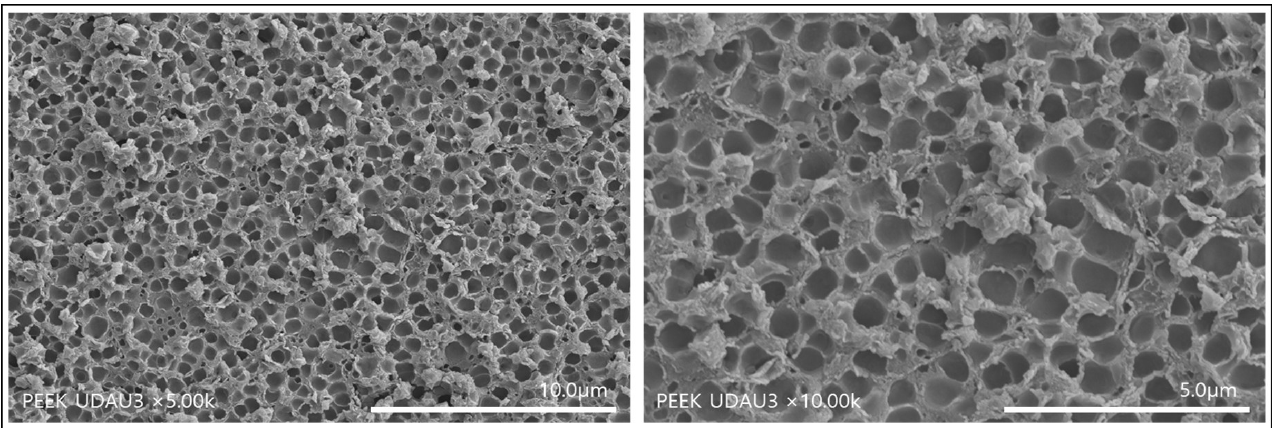
Figure 5. SEM images of porous PEEK coated with polydopamine ( a ) and porous PEEK sequentially immobilized with dopamine and collagen ( b ).